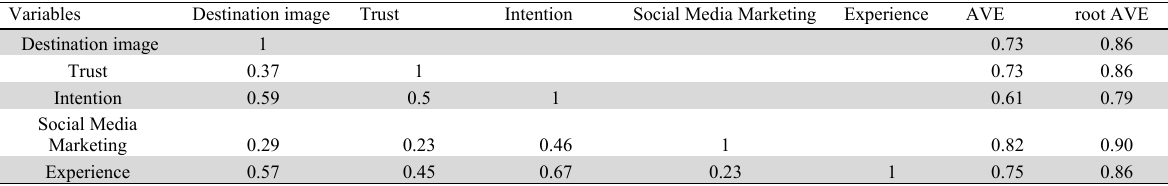
EVA Calculation Results and Correlation Values Between Latent Variables Variables